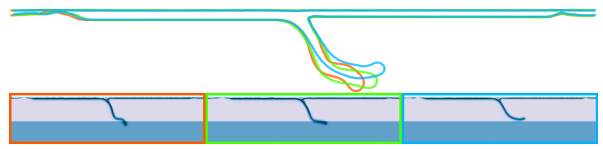
Figure 8. 1550K isotherm for models 18 (left/orange), 17 (cen- ter/green), and 16 (right/blue). Surface plates are 80km thick and have a maximum viscosity of 10 25 Pas; the slab strength for mod- els 18, 17, and 16 is 10 25 Pas, 10 24 Pas, and 10 23 Pas respectively. Subfigures show viscosity for each